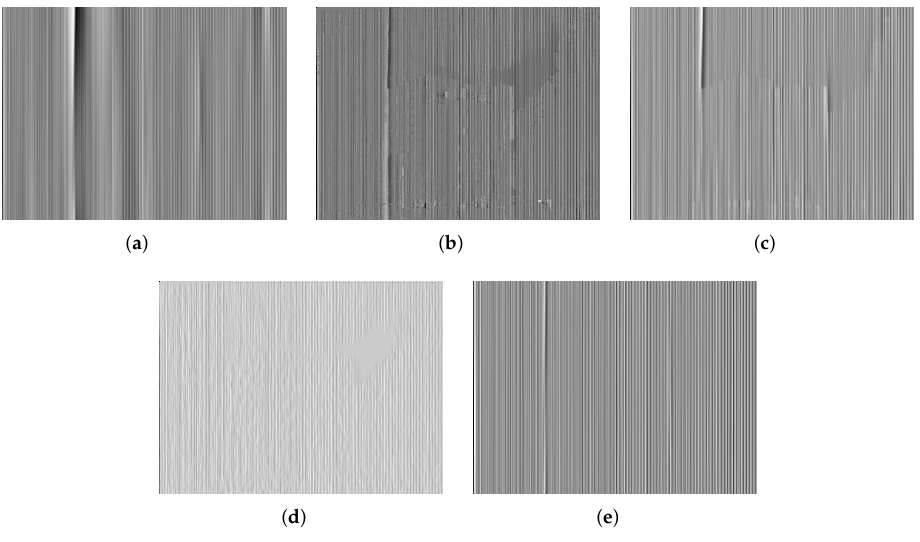
Figure 11. NUN results for Building. ( a ) WTSF; ( b ) MIRE; ( c ) GIF; ( d ) CNN; ( e ) Ours.